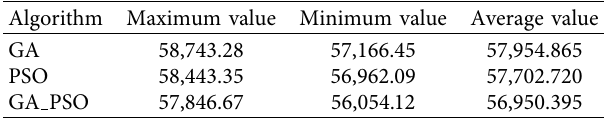
Figure 4: Load and photovoltaic power prediction. Table 1: Optimization results of power purchase cost and main- tenance cost.